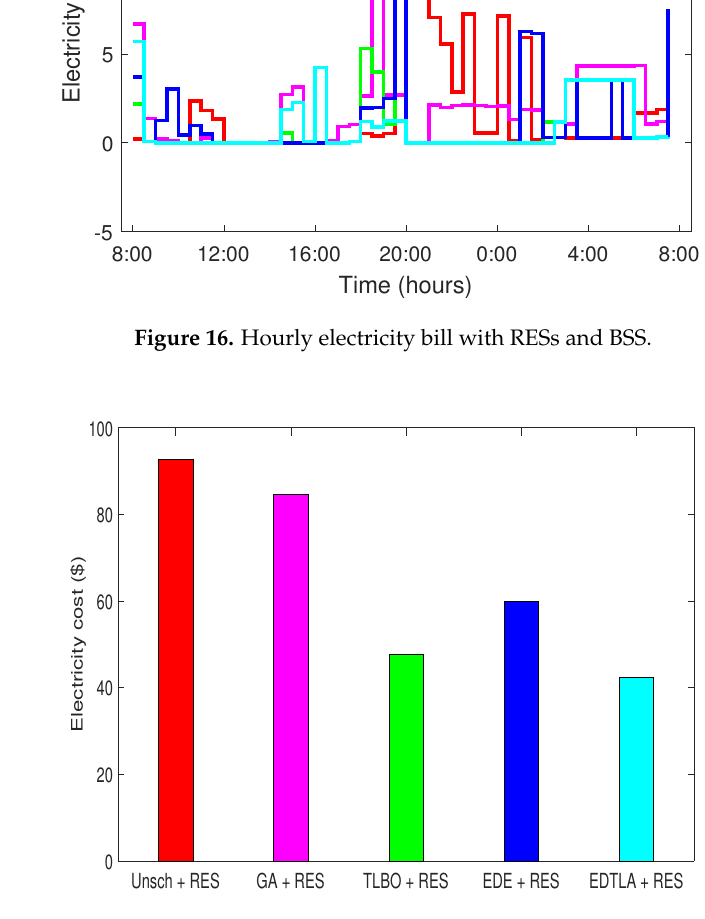
Figure 17. Daily electricity bill with RESs and